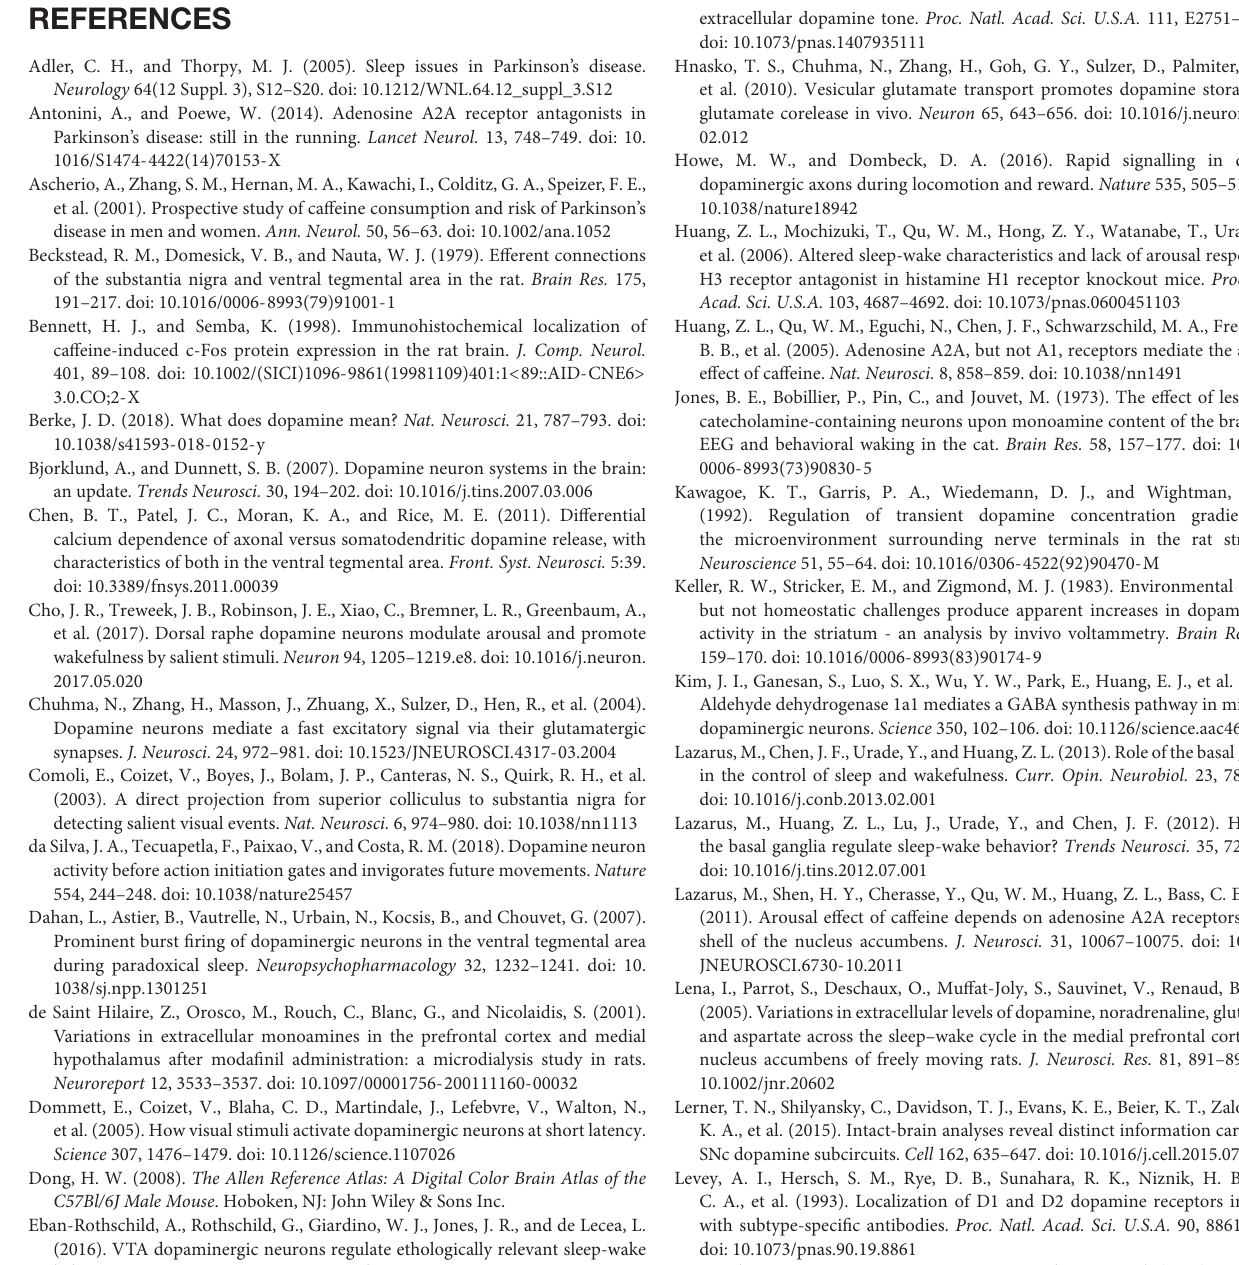
Average fluorescence before and after onset of the light flash ( t = 4.486, P = 0.0463). (E) Up panel: example traces of the fluorescence signal, EEG, and EMG before and after the onset of air release during awake. Down panel: (Left) The time course of the striatal dLight1.1 signal in response to air delivery. (Right) Average fluorescence before and after onset of the air delivery ( t = 0.4803, P = 0.6784). (F) Up panel: example traces of the fluorescence signal, EEG, and EMG before and after the onset of TMT delivery during awake. Down panel: (Left) The time course of the striatal dLight1.1 signal in response to TMT delivery. (Right) Average fluorescence before and after onset of the TMT delivery ( t = 0.2858, P = 0.8019).